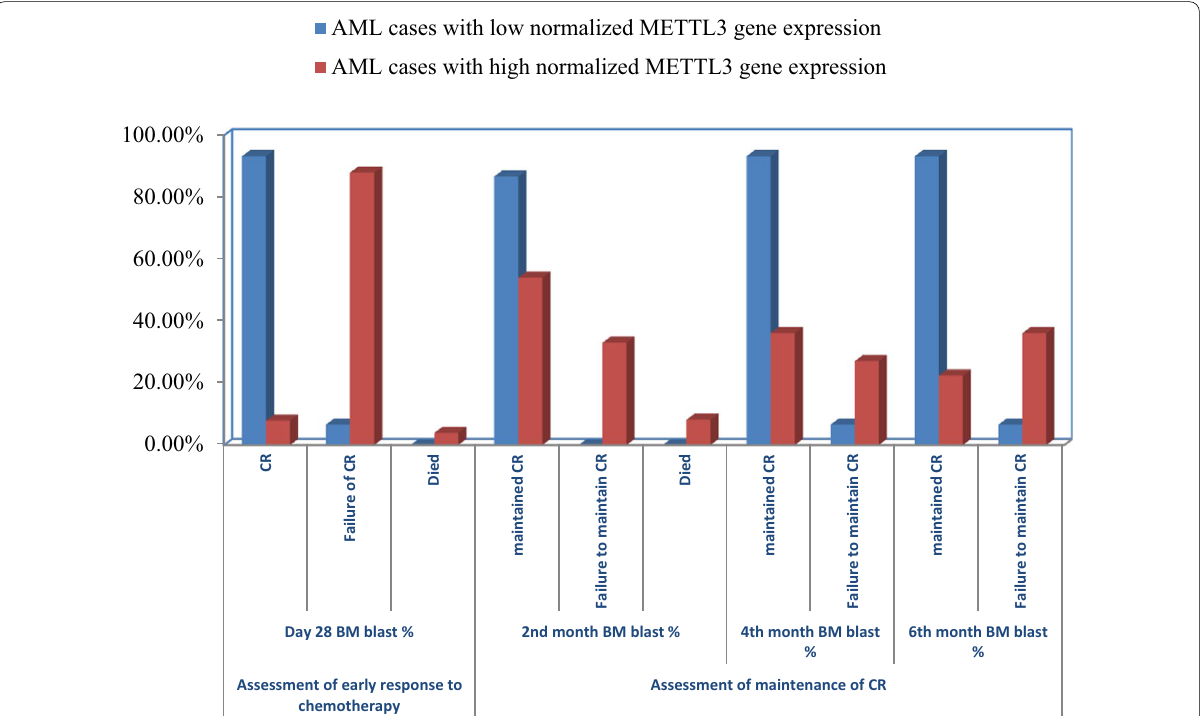
Fig. 3 Bar chart showing difference in BM blast counts during follow‑up stages in both METTL3 ‑based AML